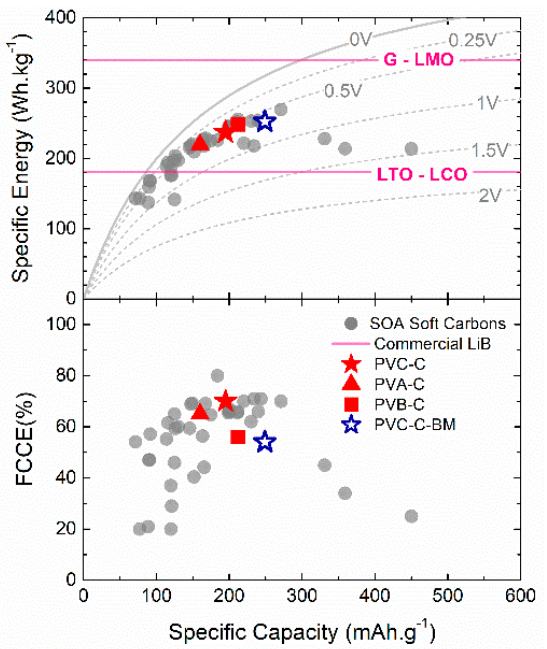
Figure 5. Overall performance (specific energy and first-cycle coulombic efficiency (FCCE) against specific capacity, top and bottom panels, respectively) comparison of the state-of-the-art (SOA) reported soft carbons (see Table S2 for details), and the polyvinyl-based SCs studied here. The specific energy has been calculated by considering the total mass of the active materials (both cathode and anode) and employment of the Faradion layered oxide as the cathode (mAh·g − 1 at 3.2 V). Commercial Li-ion cell based on Li 4 Ti 5 O 12 -LiCoO 2 (LTO-LCO) and graphite-LiMn 2 O 4 (G-LMO) with moderate specific energy at active materials is represented for the sake of comparison.